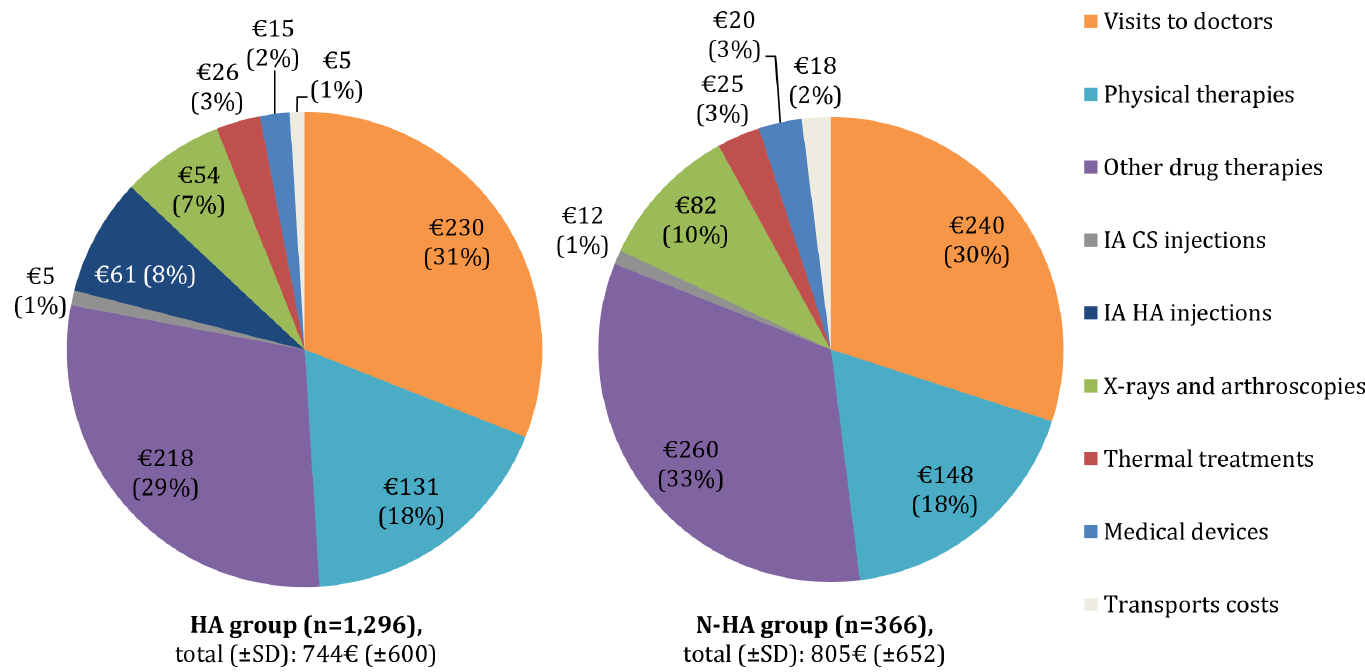
Fig 3. Share of mean of total ambulatory care costs the year before TKR. HA group: patients who receivedat least one IA HA injectionduringtheir follow-upperiod, N-HA group: patients who receivedonly CS as IA injections,TKR: total knee replacement, IA: intra-articular, HA: hyaluronic acid, CS: corticosteroids, SD: standarddeviation.Visits to doctors includevisits to rheumatologists, orthopedic surgeons, physiciansspecializedin physicalmedicine and rehabilitation or GPs.